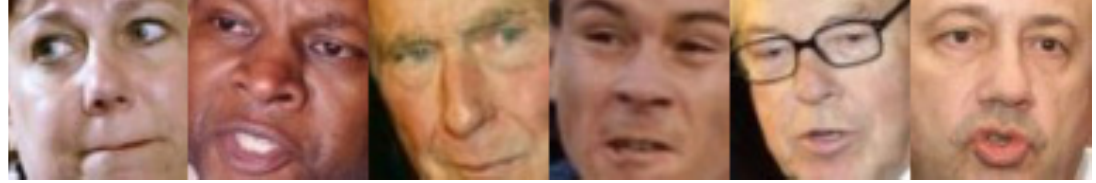
Figure 17. Sample images from the LFW face image database.